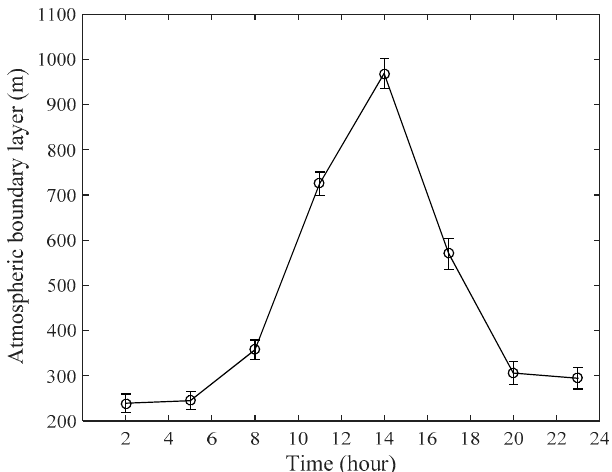
Figure 2. Diurnal variation of the boundary layer height at the MLW site. Error bars are ± 1 standard deviation of the mean.